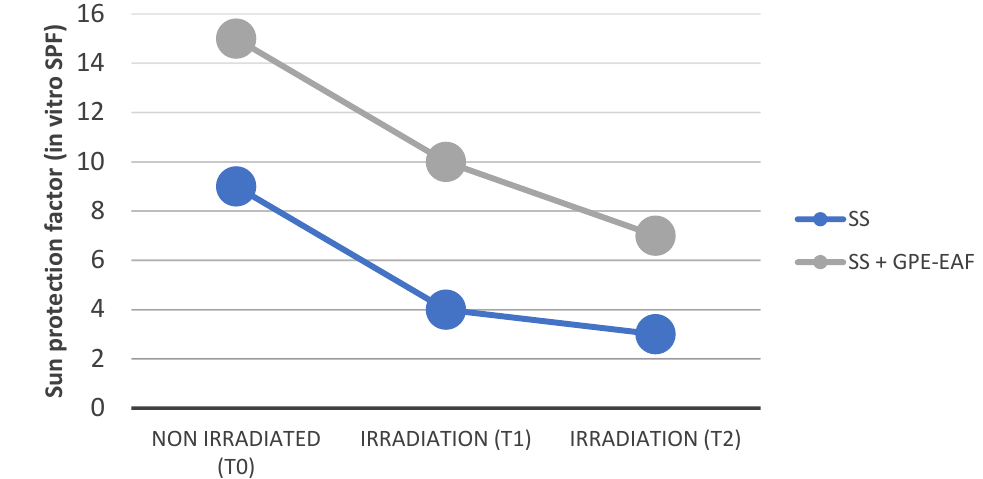
Figure 3. Photostability profile of the sunscreen systems. SS = sunscreen system; SS + GPE-EAF = sunscreen system + 10.0% ethyl acetate fraction of grape pomace extract; T1 = 1 h of irradiation; T2 = 2 h of irradiation. According Dunnett’s multiple comparisons test, SS + GPE-EAF and SS had differences in the in vitro SPF in T0 and T1 ( p < 0.001; p < 0.005,